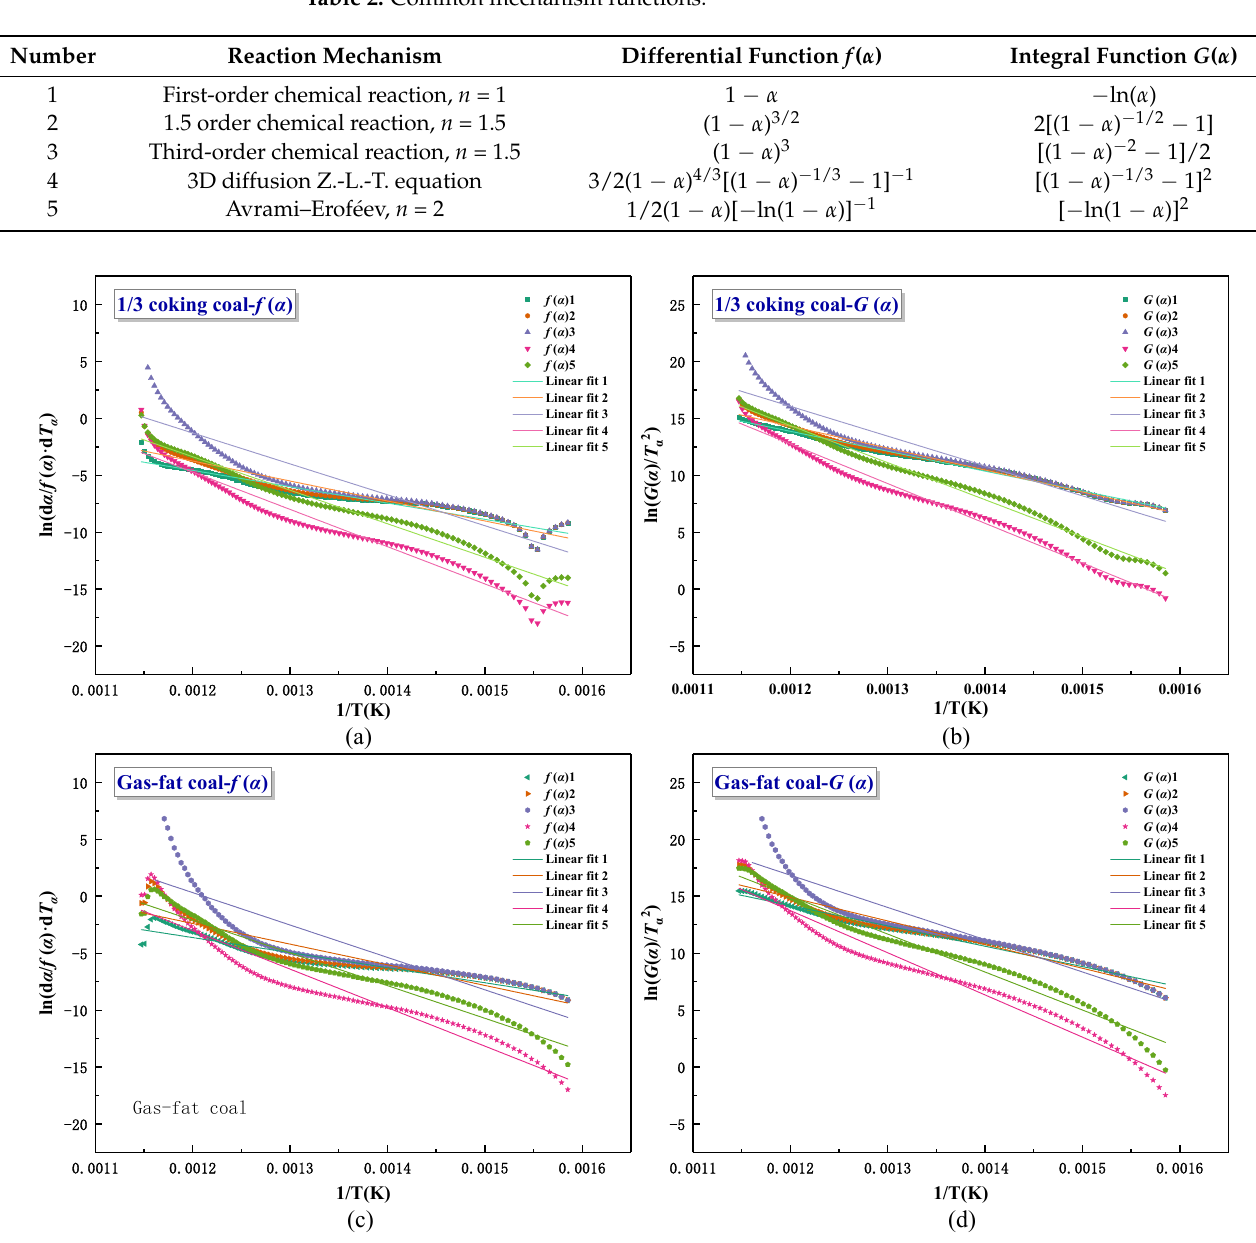
Figure 4. Fitting results for 1/3 coking coal and gas-fat coal. ( a ) 1/3 coking coal fitting by f ( α ); ( b ) 1/3 coking coal fitting by G ( α ); ( c ) Gas-fat coal fitting by f ( α ); ( d ) Gas-fat coal fitting by G ( α ).